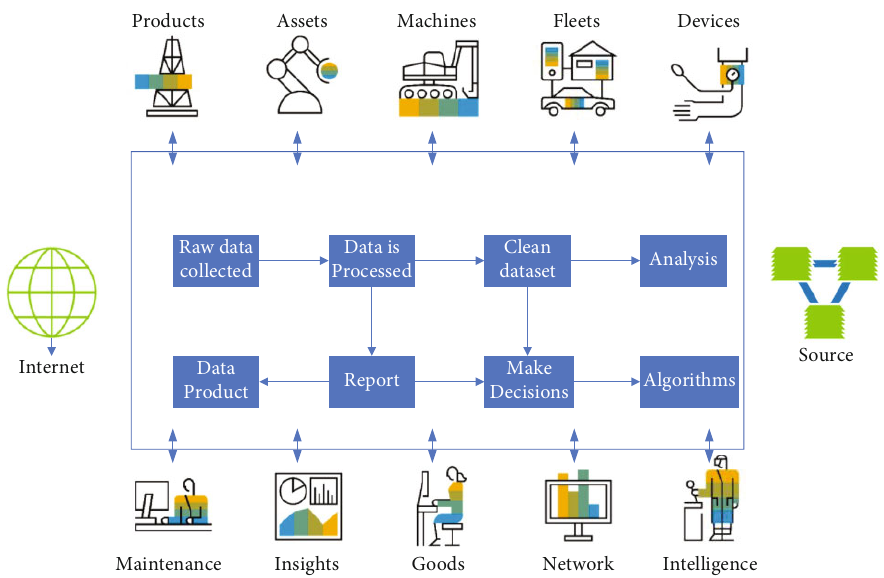
Figure 2: Relationship between server